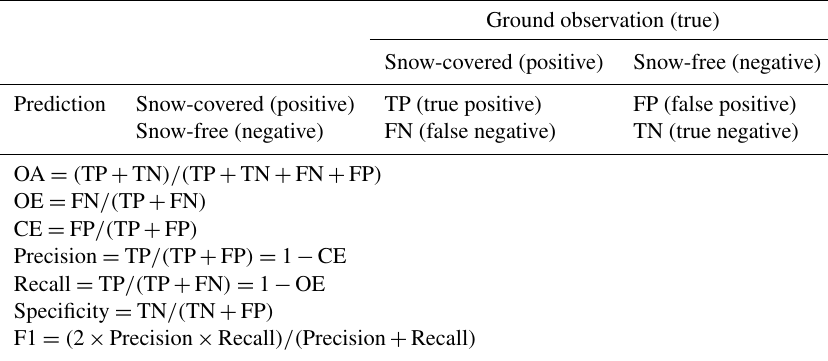
Table 3. Confusion matrix defining the accuracy of the predicted snow cover map reference to the in situ snow cover observation. The characters (TP, FP, FN, and TN) represent the number of snow-covered or snow-free records in a particular